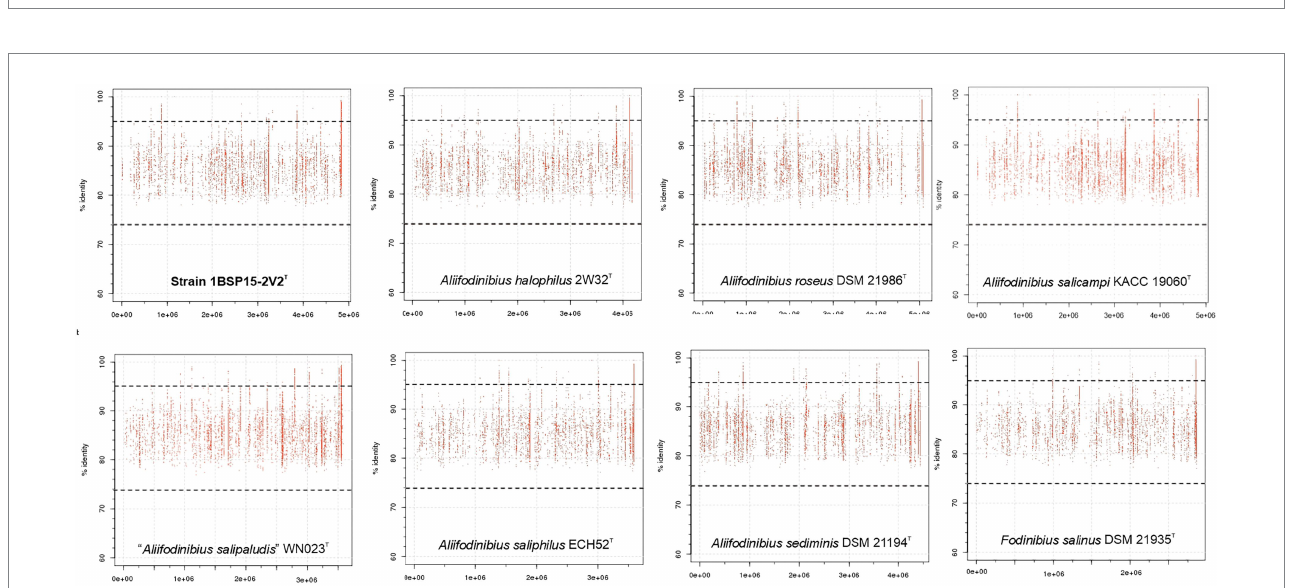
FIGURE 11 Genomic recruitment plots for the isolated strain 1BSP15-2V2 T and other type strains of species of the genera Aliifodinibius and Fodinibius against SS13 saltern metagenomic reads. X-axis represents the genome length and Y-axis represents the percentage of identity of the reads matching the genome. Red dots above the 95% threshold line indicate read assignment at the species level. A genus delineation line is also shown at 73.98% identity. The scarce read recruitment by all the species analyzed demonstrates their low abundance in this aquatic